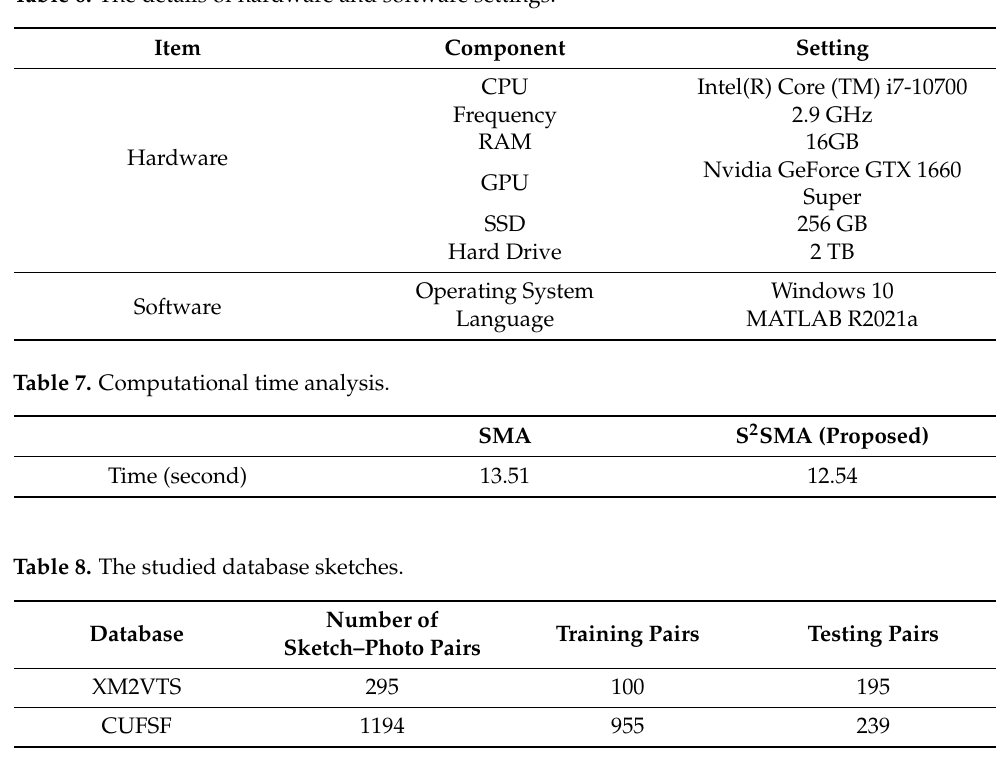
Table 6. The details of hardware and software settings.